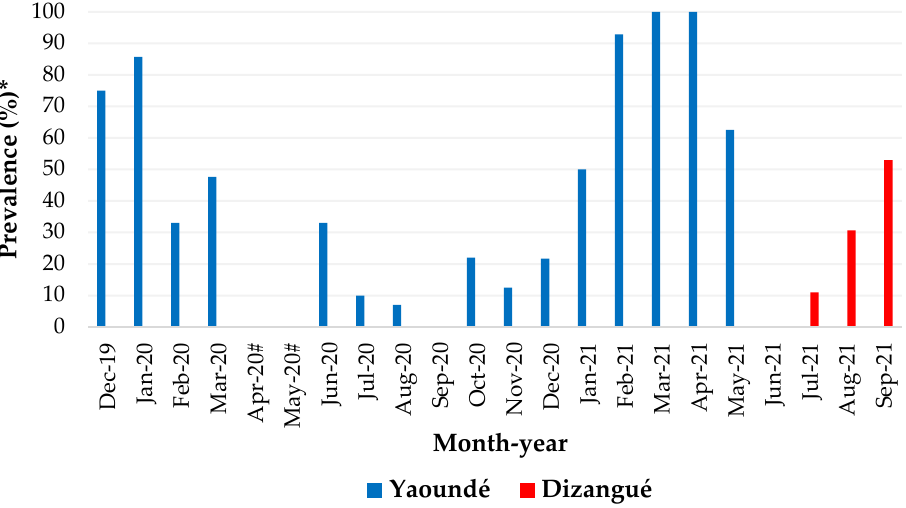
Figure 2. Prevalence of acute dengue infections in Yaoundé and Dizangué during the study period. * Cases confirmed by rtRT PCR. # No sample analysed due to COVID-19 lockdown.